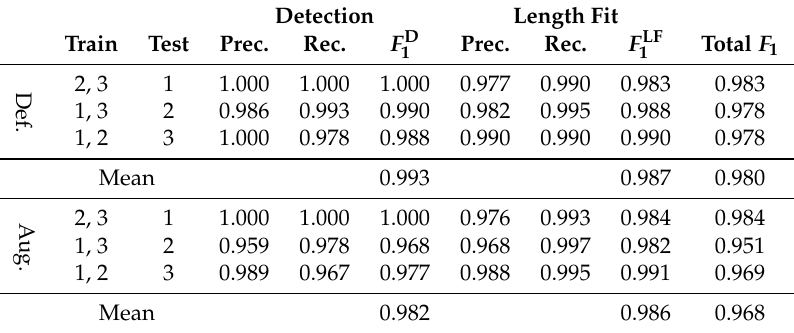
Table 4. Comparing staff line detection using cross data set training: Two parts are chosen for training while the remainder is chosen as the test data set. The training data is split into five cross folds (four folds training, one for validation) of which the average scores are shown. The total score is computed as the product of the individual F 1 -scores. The lower half of the table shows the results when using data augmentation. Detection Length Fit Train Test Prec. Rec. F D Prec. Rec. F LF Total F 1 1